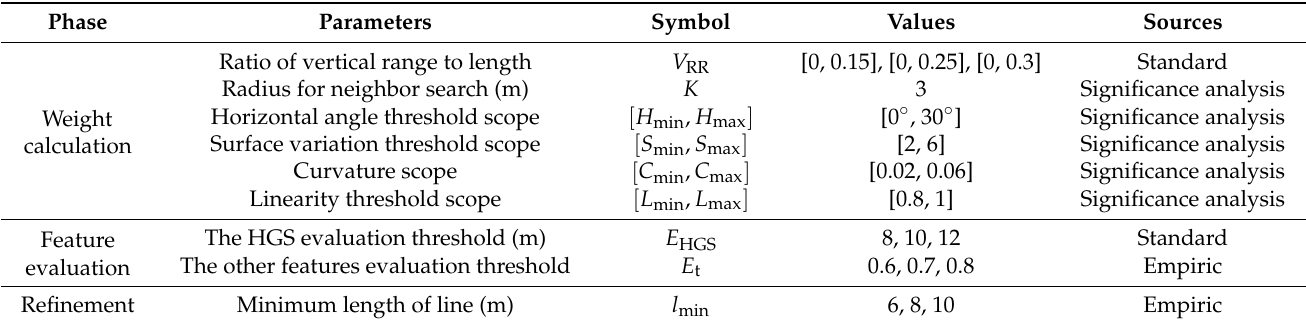
Table 4. Parameter setting for the proposed EWFE algorithm. The first column represents the parameter’s name, the second column represents the abbreviation of the parameter, the third column represents the parameter’s thresholds suggested for the EWFE algorithm, and the last column represents the parameter’s setting